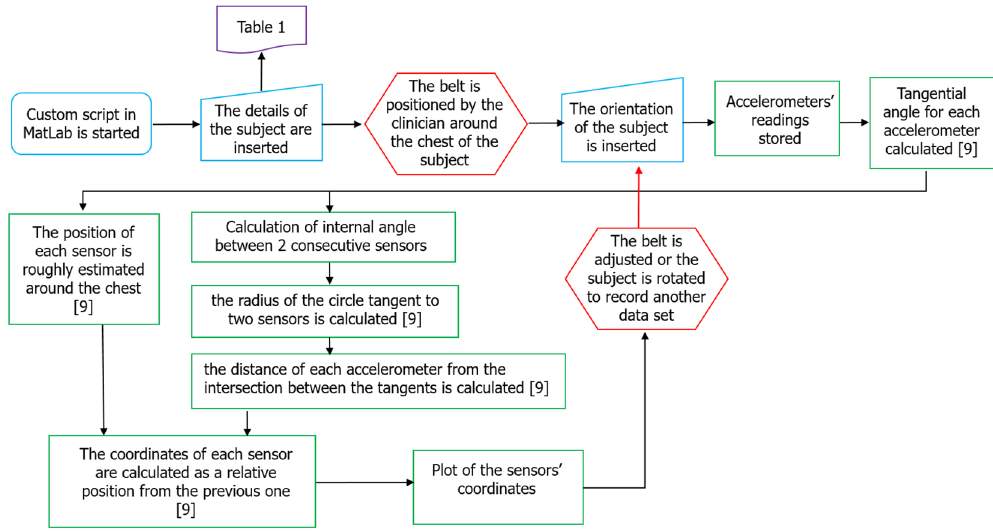
Figure 5. Algorithm steps (green) allowed to double check the data acquisition during the protocol, which was carried out by a clinician (red) supported by an engineer (blue). A previous work 9 explains the core of the